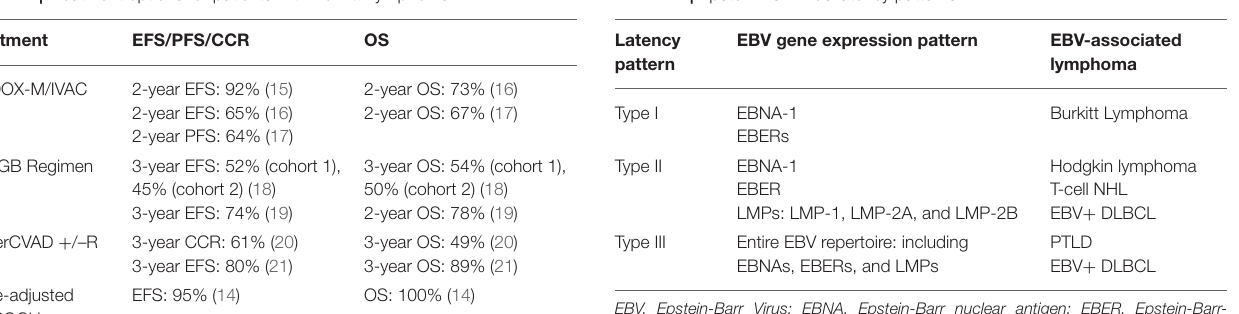
TABLE 1 | Treatment options for patients with Burkitt Lymphoma. TABLE 2 | Epstein-Barr virus latency